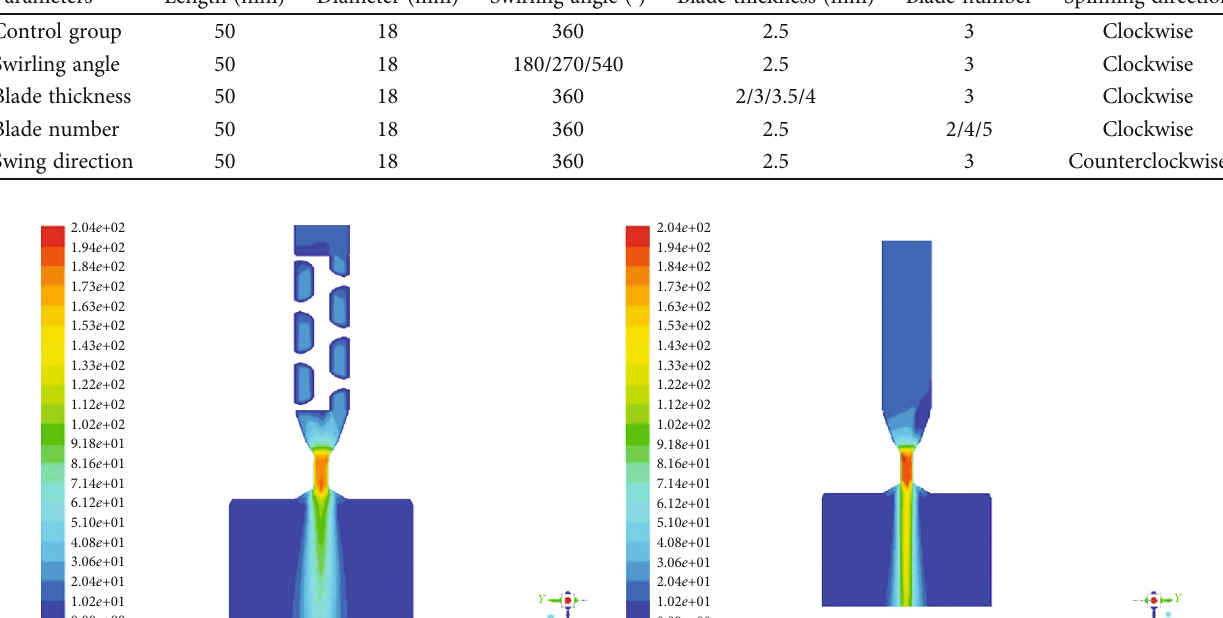
Figure 4: Cloud picture of velocity of swirling abrasive jet and direct jet.